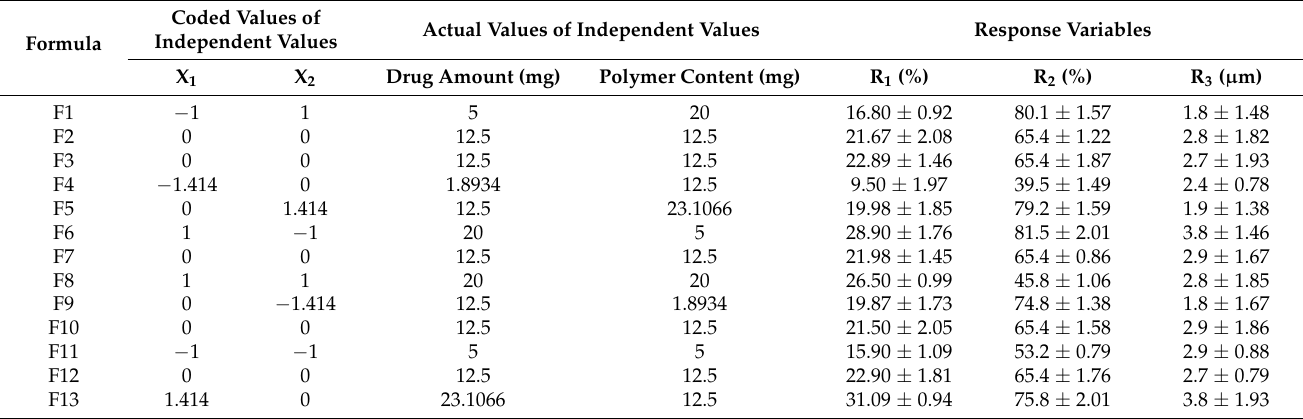
Table 1. Experimental design matrix of the central composite design with experimental